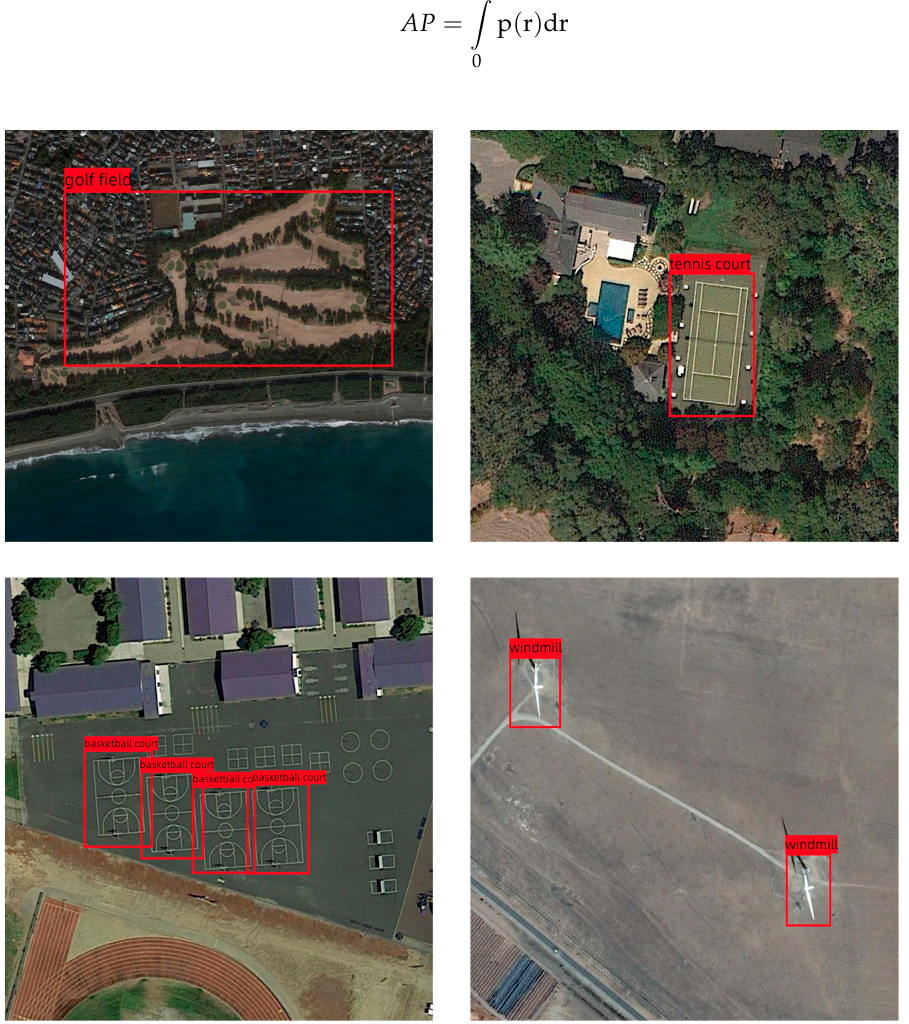
Figure 7. Remote sensing images and objects of DIOR dataset.